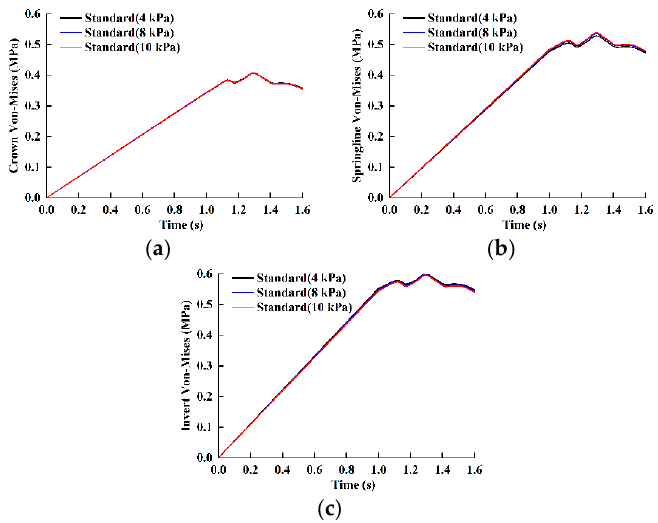
Figure 16. The Von-Mises stresses of different hoop stiffnesses of pipe under traffic load when the backfill compactness is standard: ( a ) the crown; ( b ) the springline; ( c ) the invert.